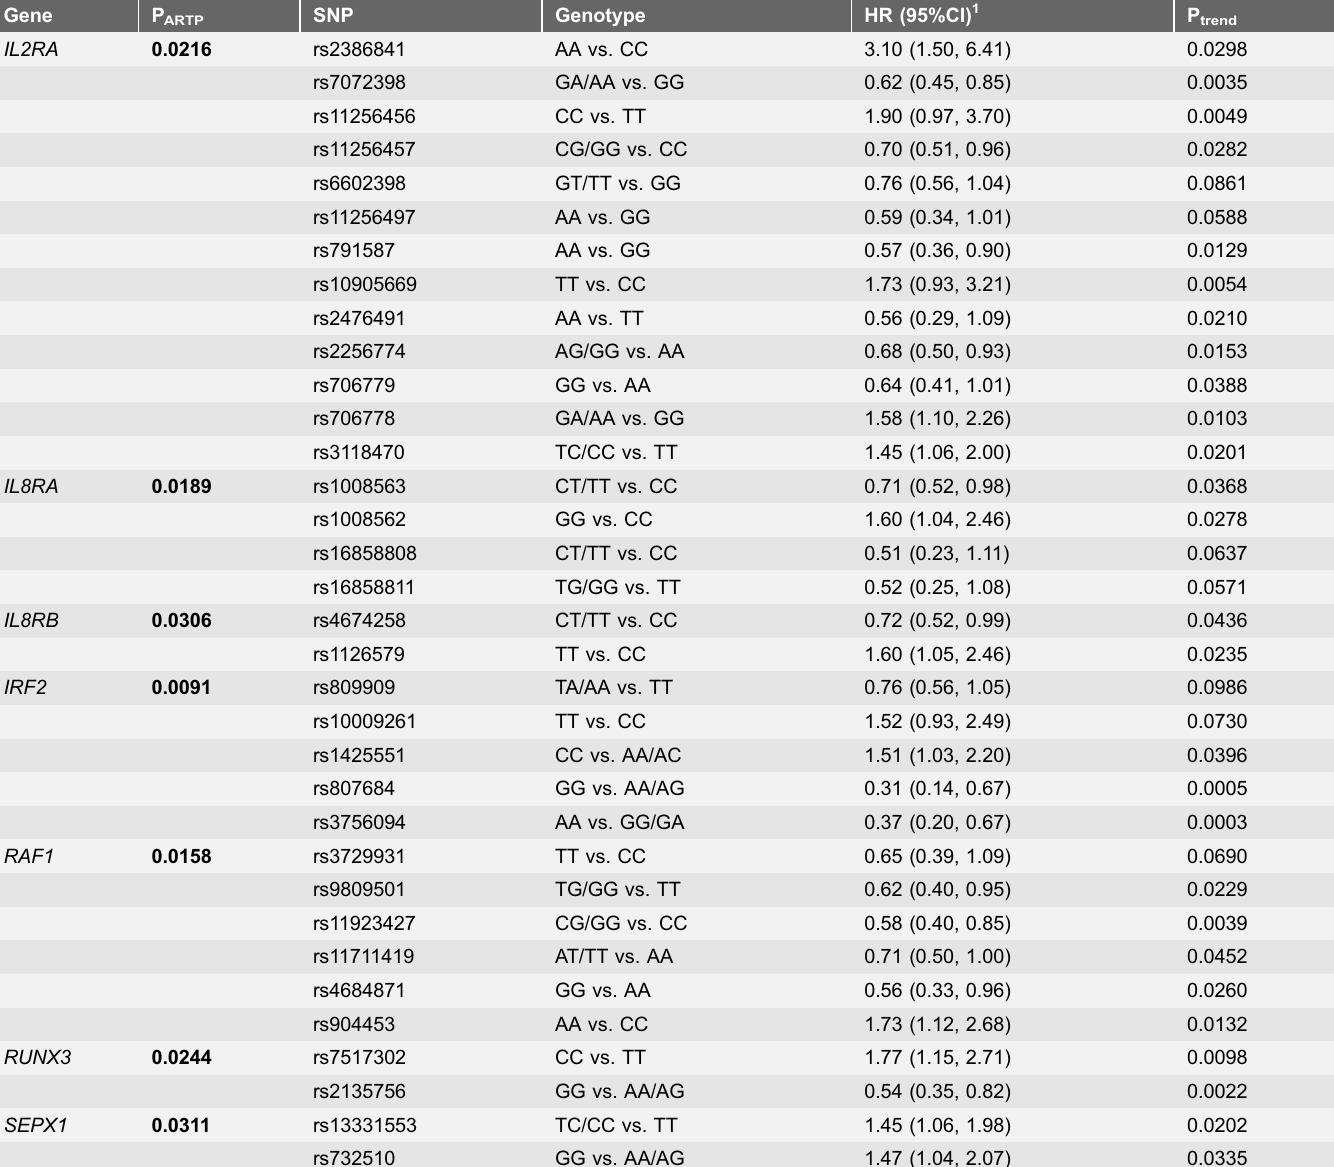
Table 4. Genes and related SNPs associated with colorectal cancer-specific mortality among patients diagnosed with rectal cancer (gene P ARTP # 0.05; SNP P trend #